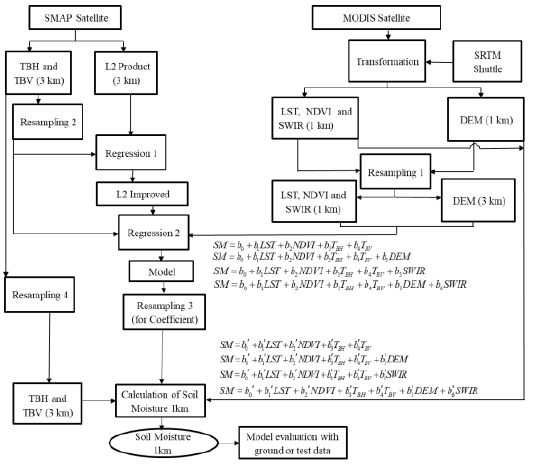
Figure 1 . Different stages of downscaling using data from different